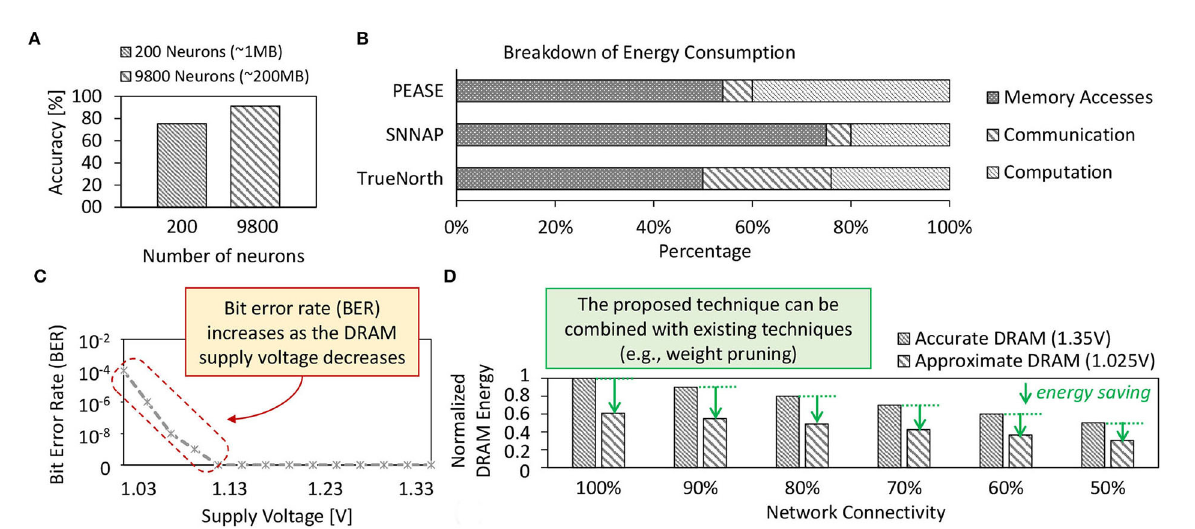
FIGURE1 (A) Accuracy profiles of small-sized and large-sized SNN models on the MNIST dataset which are obtained from our experiments. (B) Breakdown of the energy consumption of SNN processing on different SNN hardware platforms, i.e., PEASE (Roy et al., 2017), SNNAP (Sen et al., 2017), and TrueNorth (Akopyan et al., 2015); adapted from studies in Krithivasan et al. (2019). (C) Bit error rate (BER) of approximate DRAM and its respective supply voltage V supply ; adapted from studies in Chang et al. (2017). (D) The estimated DRAM energy savings achieved by our technique when combined with the weight pruning across different rates of network connectivity (i.e., synaptic connections) for a network with 4900 excitatory neurons. The results are obtained from experiments using the LPDDR3-1600 4Gb DRAM configuration and the DRAMPower simulator (Chandrasekar,